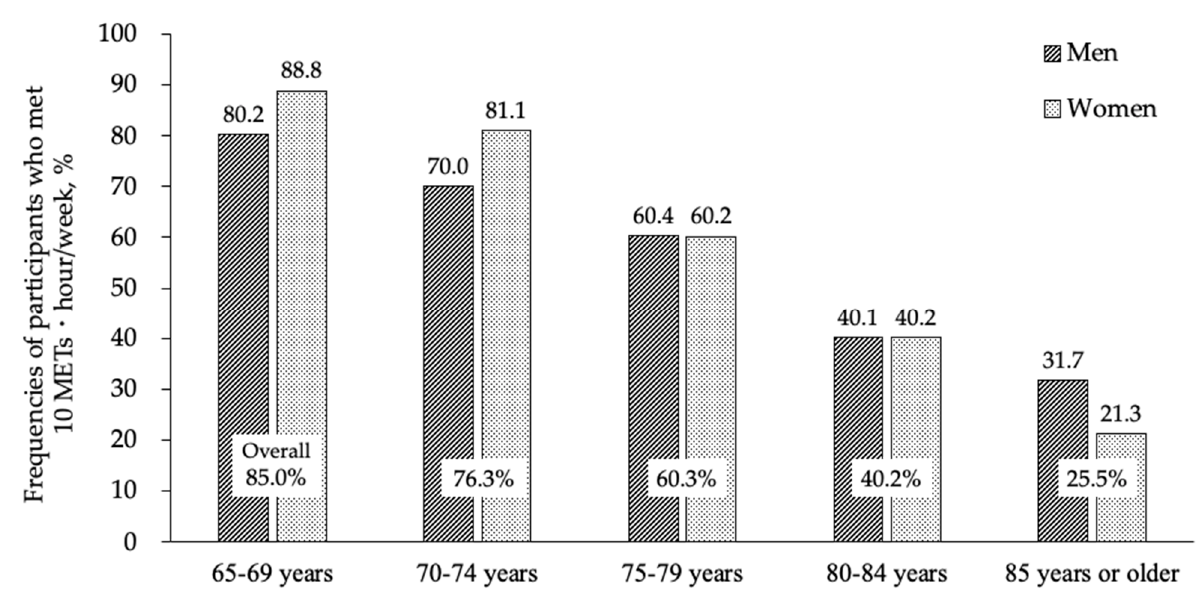
Figure 1. Percentage of participants who met 10 metabolic equivalents (METs) · hour/week guideline only considering MVPA by sex and age.